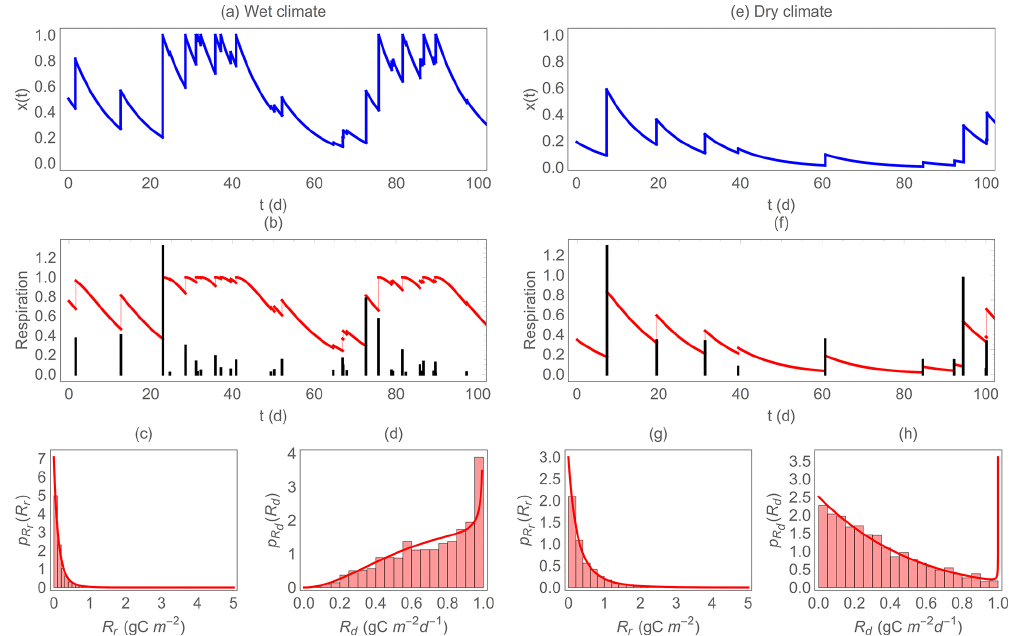
Figure 3. Example of the dynamics of soil moisture and respiration for a wet (a–d) and a dry climate (e–h) . Top panels (a) and (e) show the simulated trajectories of normalized soil moisture x ; the middle panels (b) and (f) show the trajectories of respiration during dry periods (red solid curves, R d ) and the respiration pulse at rewetting (black vertical bars, R r , on the same scale despite different units); the bottom panels (c) , (d) , (g) , and (h) show the probability density functions of R r and R d ( p R histograms of the simulated data. In this figure, R r , max = 5gCm − 2 , R d , max = 1gCm − 2 d − 1 , b = 0 . 1, γ = 5, η = 0 . 1d − 1 , and λ = 0 . 3 and 0.1d − 1 ( a – d and e – h ,